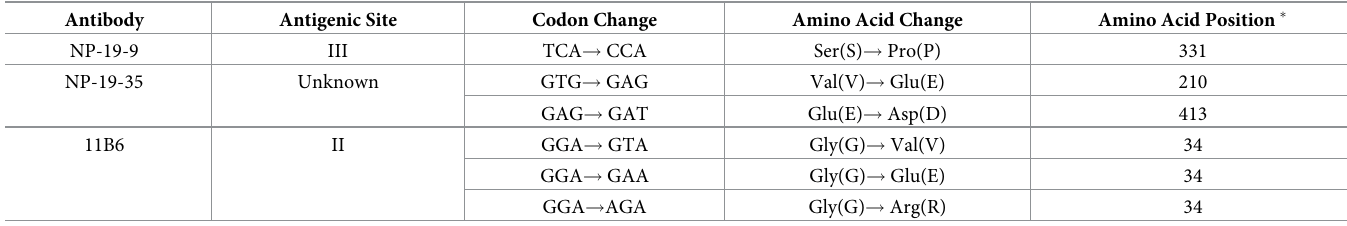
Table 3. Determination of antigenic sites for the mAbs.